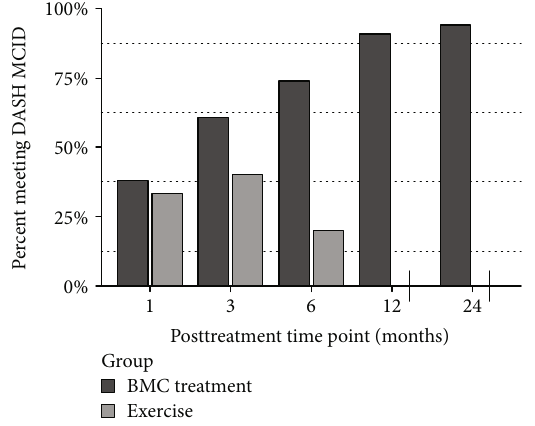
Figure 3: Percentage of patients who met MCID for DASH.